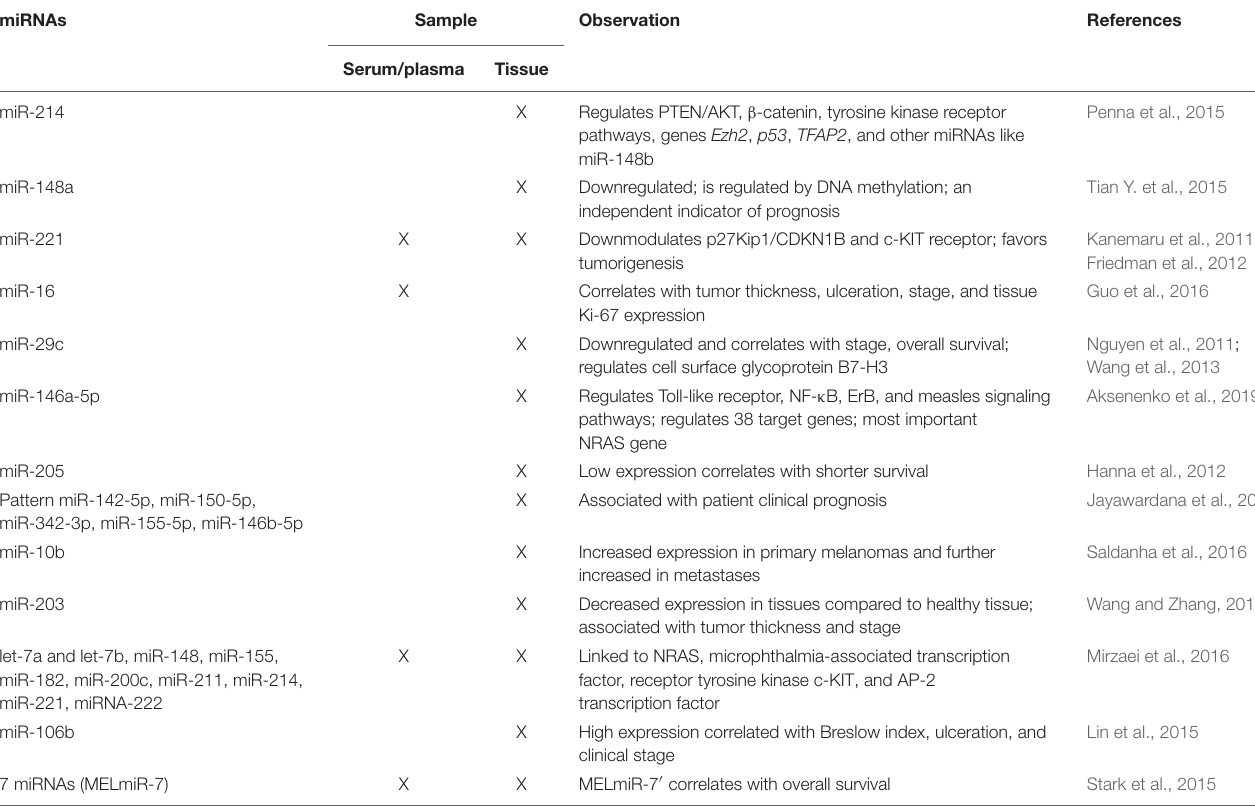
TABLE 2 | Overview of the main miRNAs found in melanoma tissue or/and in circulation in patients diagnosed with cutaneous melanoma.